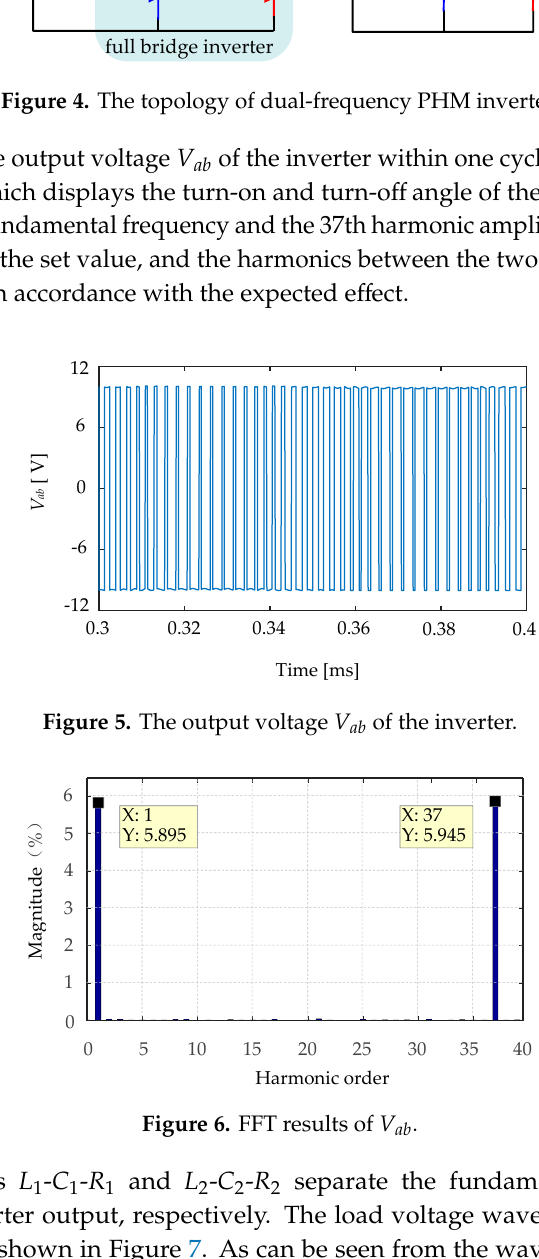
Figure 7. Load voltage of two resonant branches. 5.3. Experimental Verification An experimental platform was set up to verify the proposed algorithm, as shown in Figure 8. The experimental system used an FPGA chip EP4CE10F17C8 as the controller to generate dual- frequency PHM signals. After obtaining the predetermined switching angle by off-line calculation of the algorithm, the control resolution of the system hardware was improved by doubling the clock frequency of the FPGA system to 400 MHz, which improved the experimental precision of the dual- frequency PHM signal. Considering that the inverter works under high-frequency switching, a GaN-